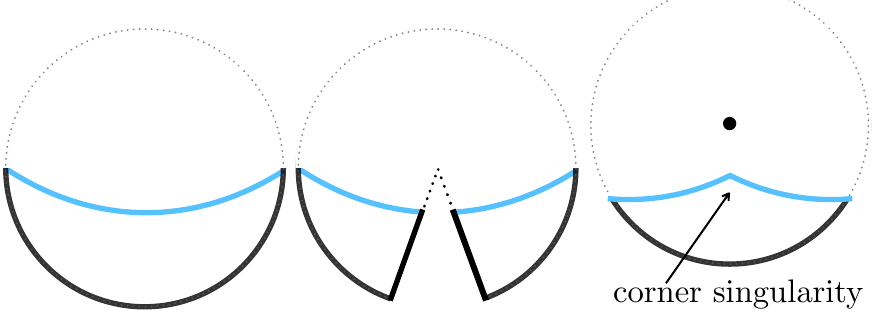
Figure 12 . Cutting and pasting the spacetime with a negative tension brane (shown in blue). Starting from the vacuum configuration (left), excluding its portion in a symmetric way (middle) and then pasting the two boundaries, we get a configuration with a corner defect localized on the